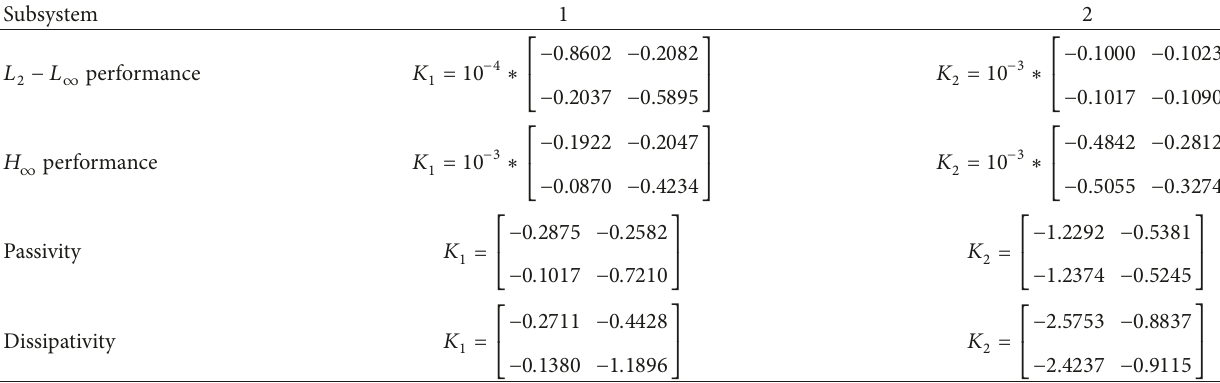
Table 4: Controller gain of the multiplicative form controller uncertainty for each